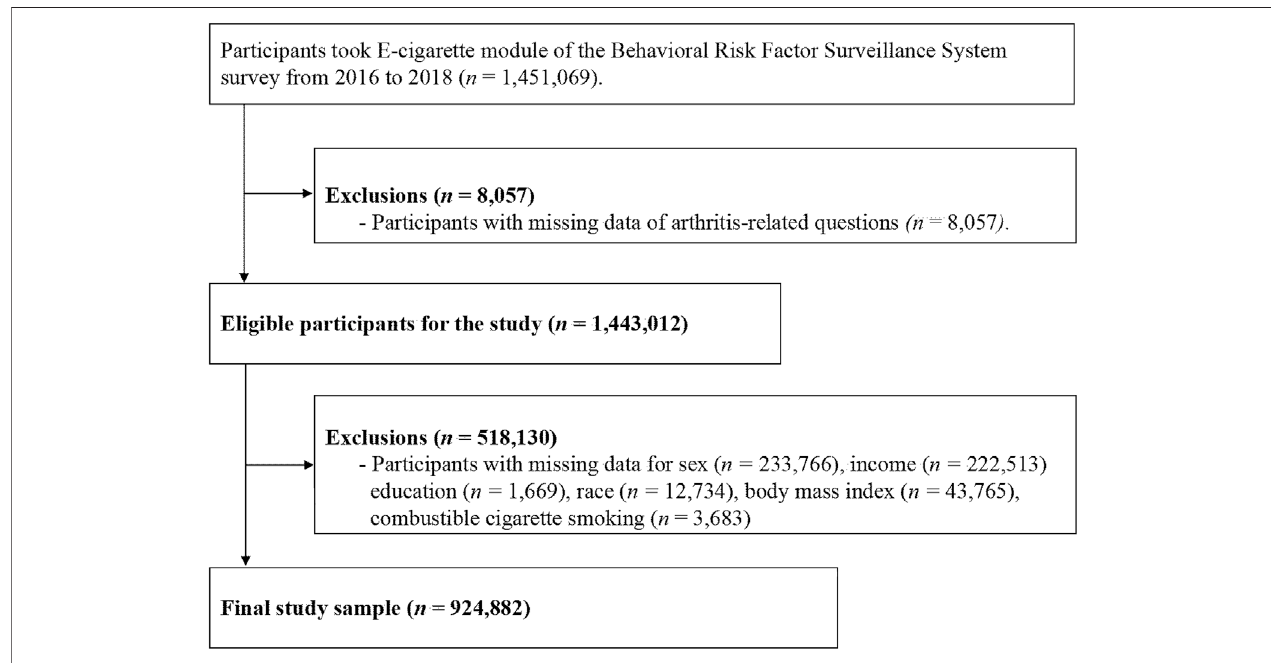
FIGURE 1 | Flowchart of study